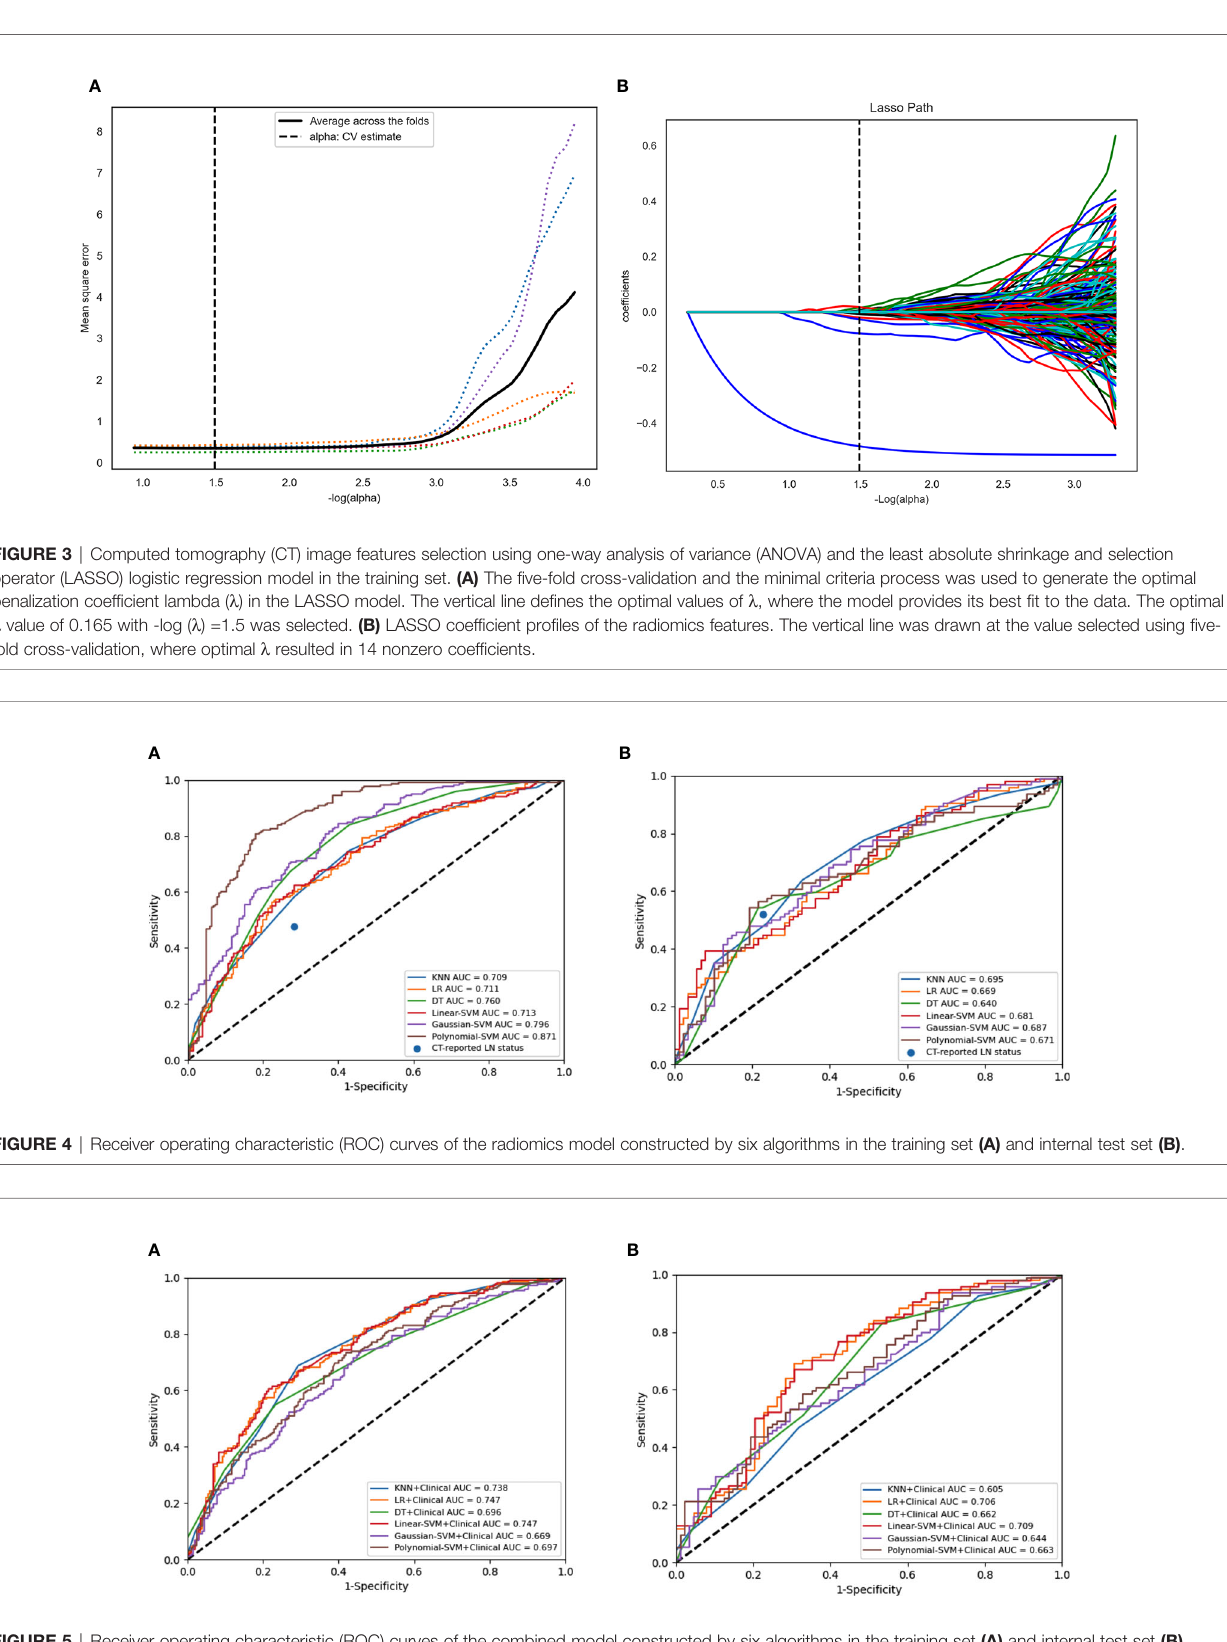
Frontiers in Endocrinology |